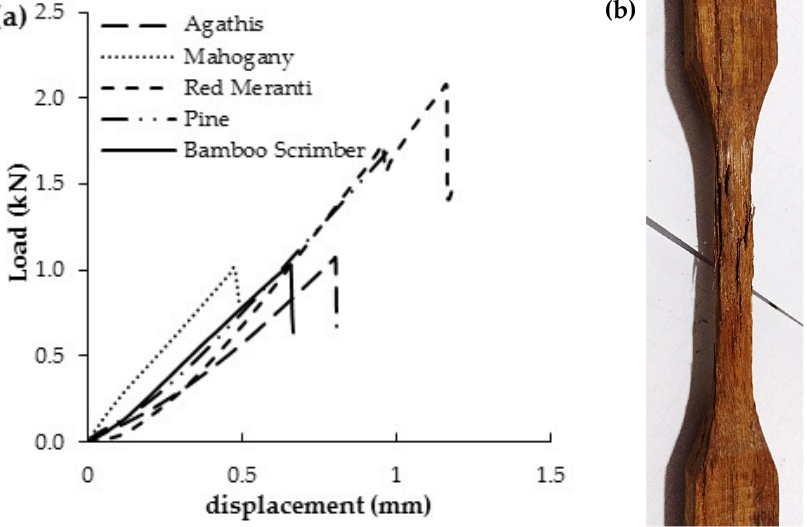
Figure 5. Tension parallel-to-fiber ( a ) results and ( b ) specimen failures in scrimber. This failure type of scrimber in tension parallel-to-fiber was splintering tension. The failure type found in this study differs from the experimental study by Huang [63] and Sharma [37]; the failure mode of engineered bamboo is similar to wood in that the tension test is brittle, with the fibers fractured. The difference in failure between scrimber and timber loaded in tension parallel-to-fiber is that the fibers separate in scrimber, then fracture as the final failure at maximum load. While in timber, the fiber did not separate but was immediately